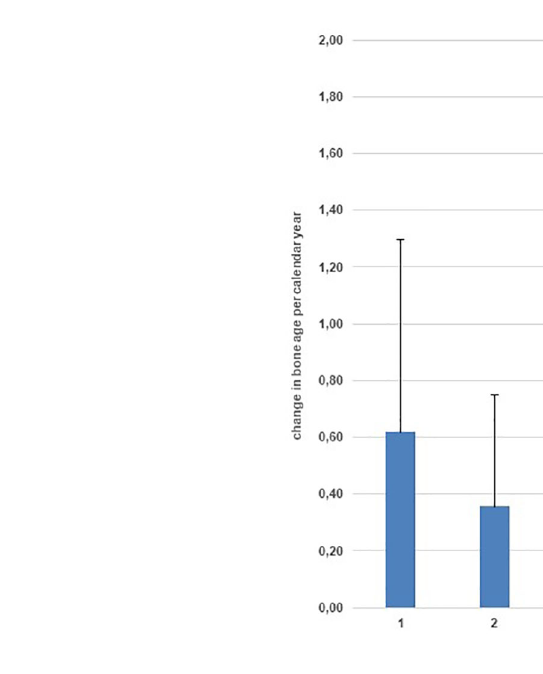
FIGURE 4 Yearly bone age progression during treatment and during 2 years of